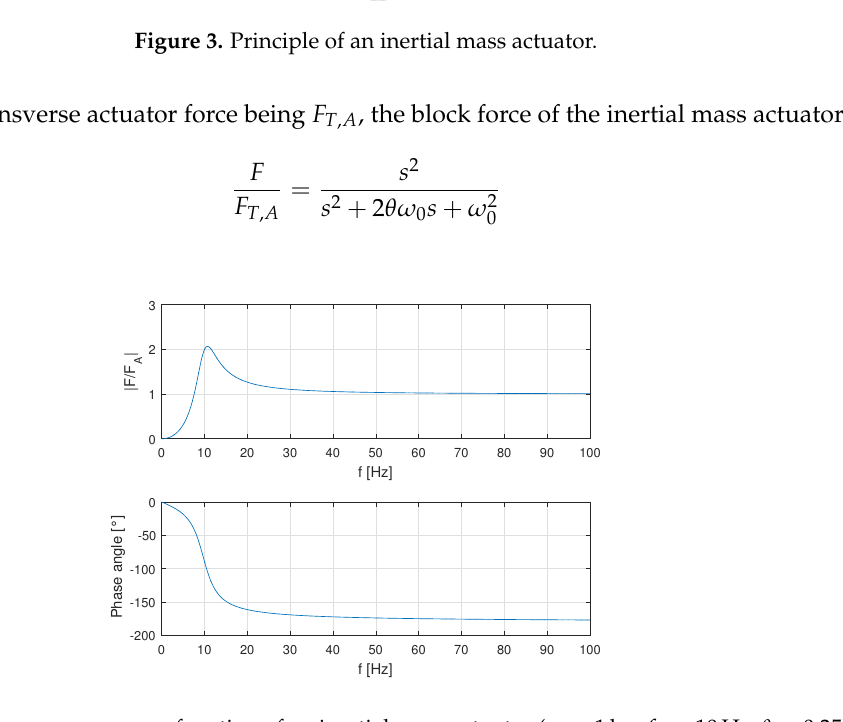
Figure 4. Frequency response function of an inertial mass actuator ( m = 1kg, f 0 = 10Hz, θ = 0.25).